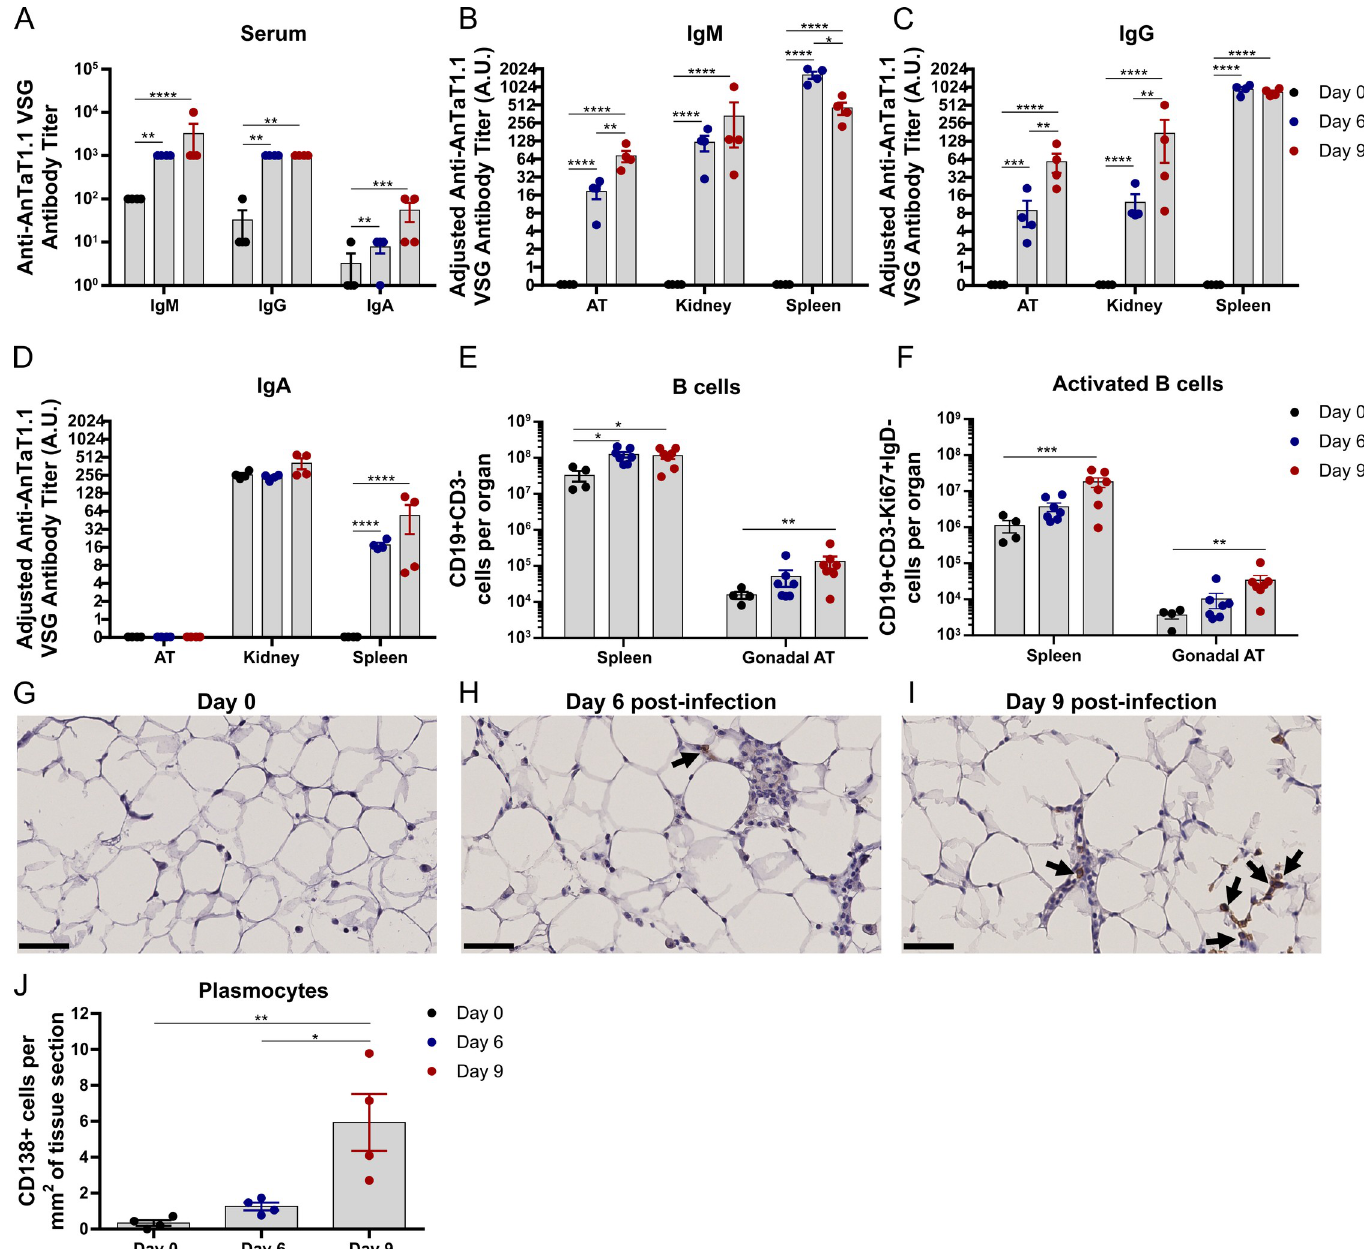
Fig 5. Dynamics of immunoglobulins, B cells and plasmocytes during infection. (A) Antibody titers of anti-AnTaT1.1 VSG in the serum. Antibody titer normalized to tissue mass used to prepare cell-free suspensions in arbitrary units (A.U.) of (B) IgM, (C) IgG and (D) IgA. Number of (E) total B cells and (F) activated B cells in the spleen and gonadal AT. Immunohistochemistry detection of (anti-CD138 antibody) plasmocytes at days (G) 0, (H) 6 and (I) 9 post-infection. (J) Quantification of plasmocytes in tissue sections. (G-I) Black arrows indicate CD138+ cells and scale bars represent 50 μ m, original magnification 40x. Statistical analysis was performed with (A-F) two-way ANOVA and (J) one-way ANOVA using Sidak’s test for multiple comparisons. � , P < 0.05; �� , P < 0.01; ��� , P < 0.001; ���� , P <